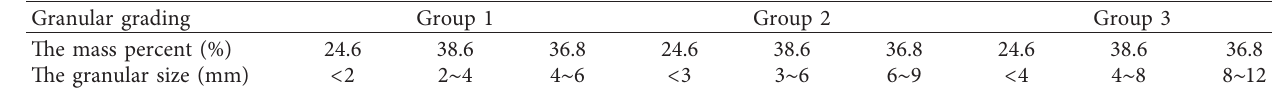
Table 5: Summary of granular